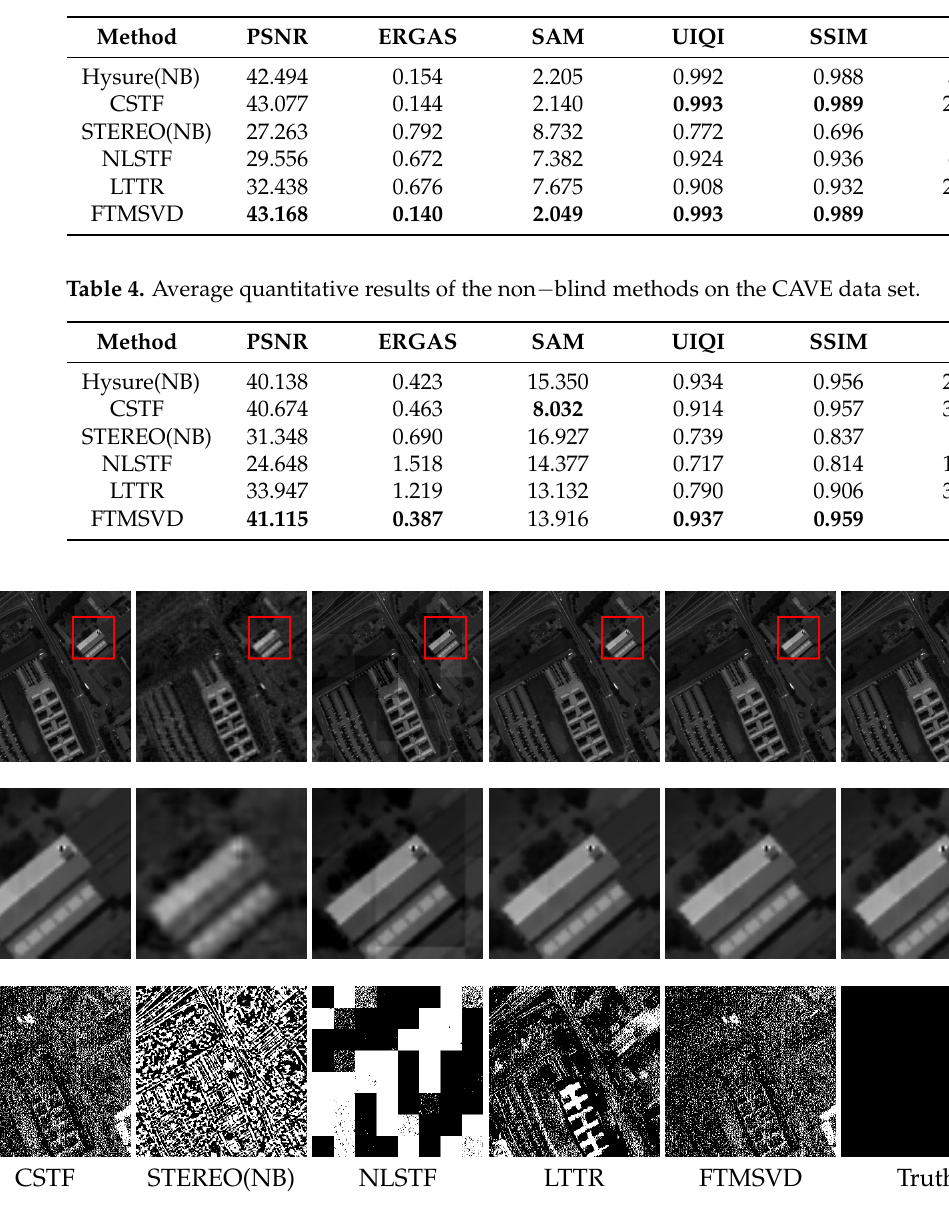
Table 3. Average quantitative results of the non − blind methods on the Pavia University data set.